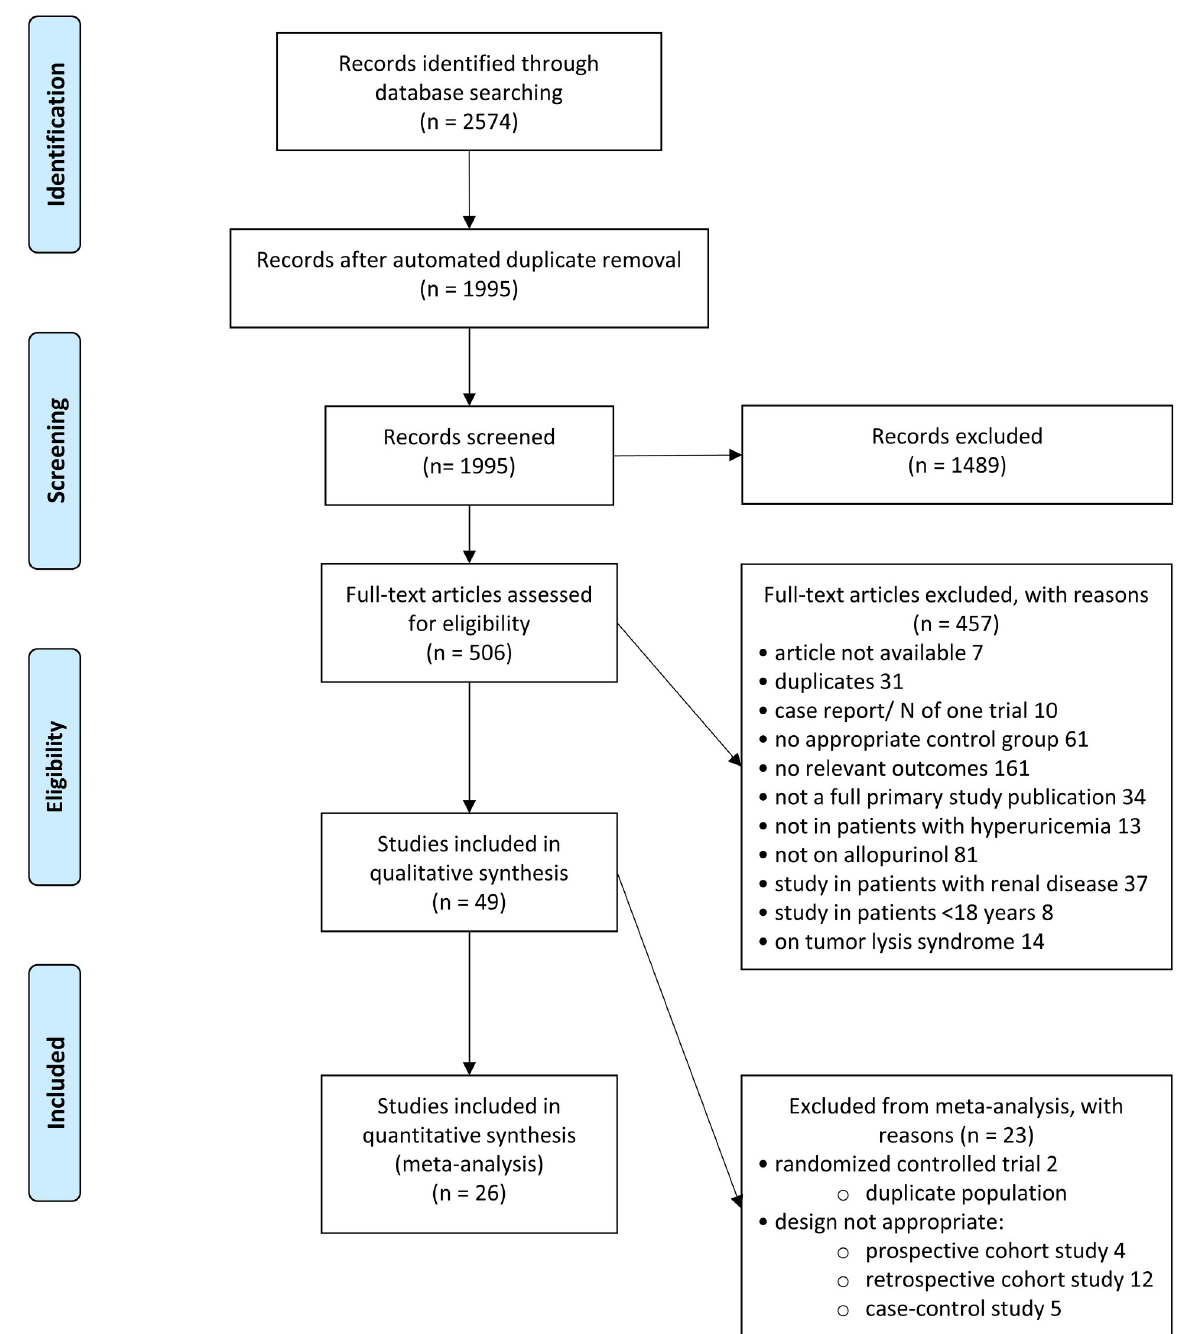
Fig 1. Flow diagram of study selection process. � there were 4 publications of 2 RCTs. Only 2 of these publications were included in the meta- analysis the other 2 were excluded.